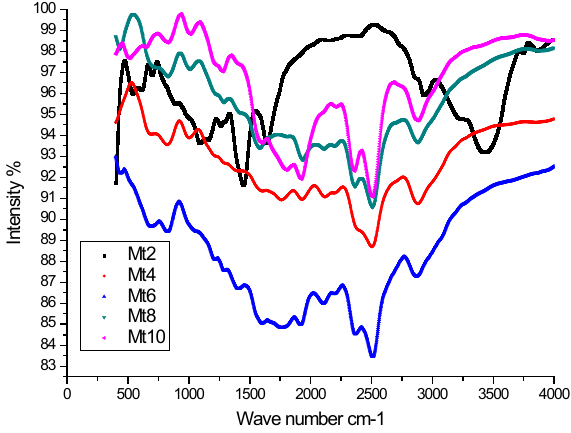
Figure 2: FTIR for Mt2, Mt4, Mt6, Mt8 and